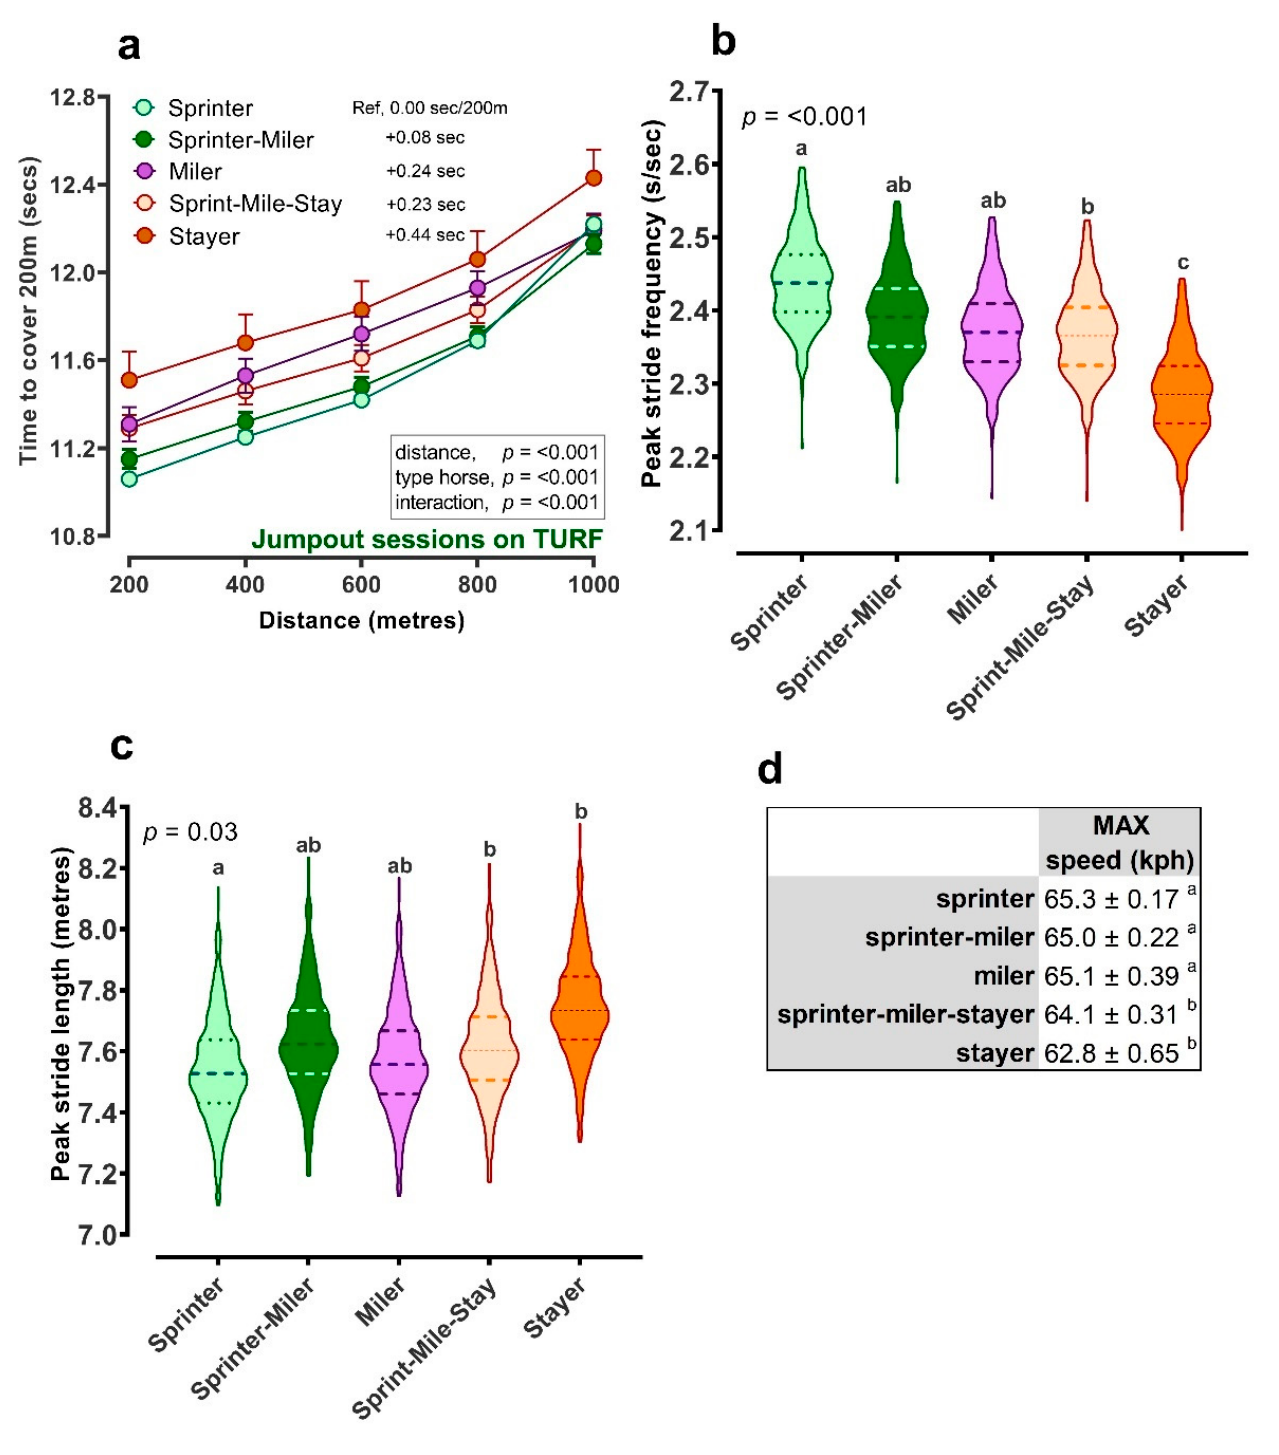
Figure 1. Training data during jumpout for different types of racehorse. ( a ) data are estimated marginal means ± SEM for consecutive 200 m segments ( b ) data are for all horses’ peak stride frequency or ( c ) peak stride length during jumpout training sessions, ( d ) mean ± 1SD speed, according to category of racehorse. All data obtained from an ‘Equimetre’ used at a single racing yard in Victoria, Australia ( n = 378 different racehorses, n = 1013 different ‘jumpout’ training sessions). Type of racehorse applied retrospectively to training data after competing in races of known